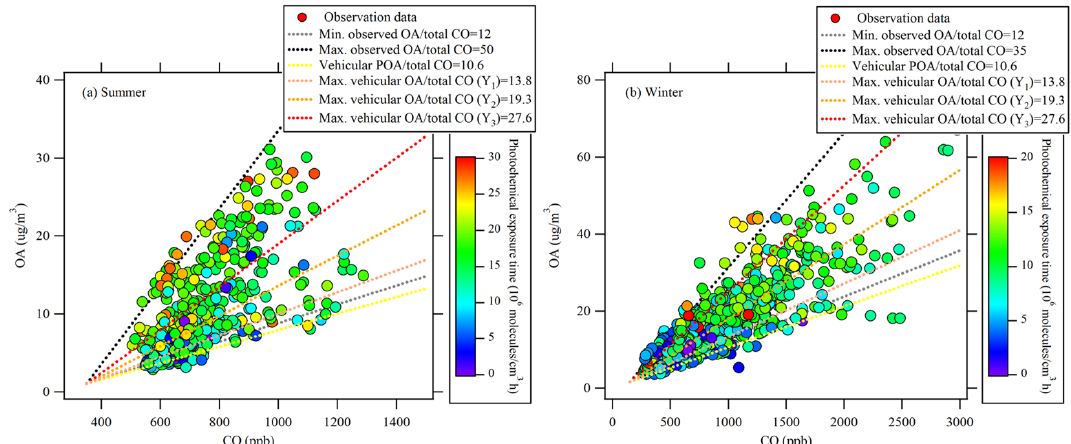
Figure 6. Relationship of measured OA and CO concentrations color-coded by the photochemical exposure in the summer (a) and winter (b) of 2013 in urban Shanghai according to Eq. (4). Minimum and maximum ratios of observed OA to CO concentrations are shown by dotted gray and black lines. Vehicular POA/total CO is shown by the dotted yellow line. The minimum and maximum OA formation ratios of vehicle emissions calculated with three different SOA yields of Y1, Y2 and Y3 are shown by the dotted pink, orange, and red lines,